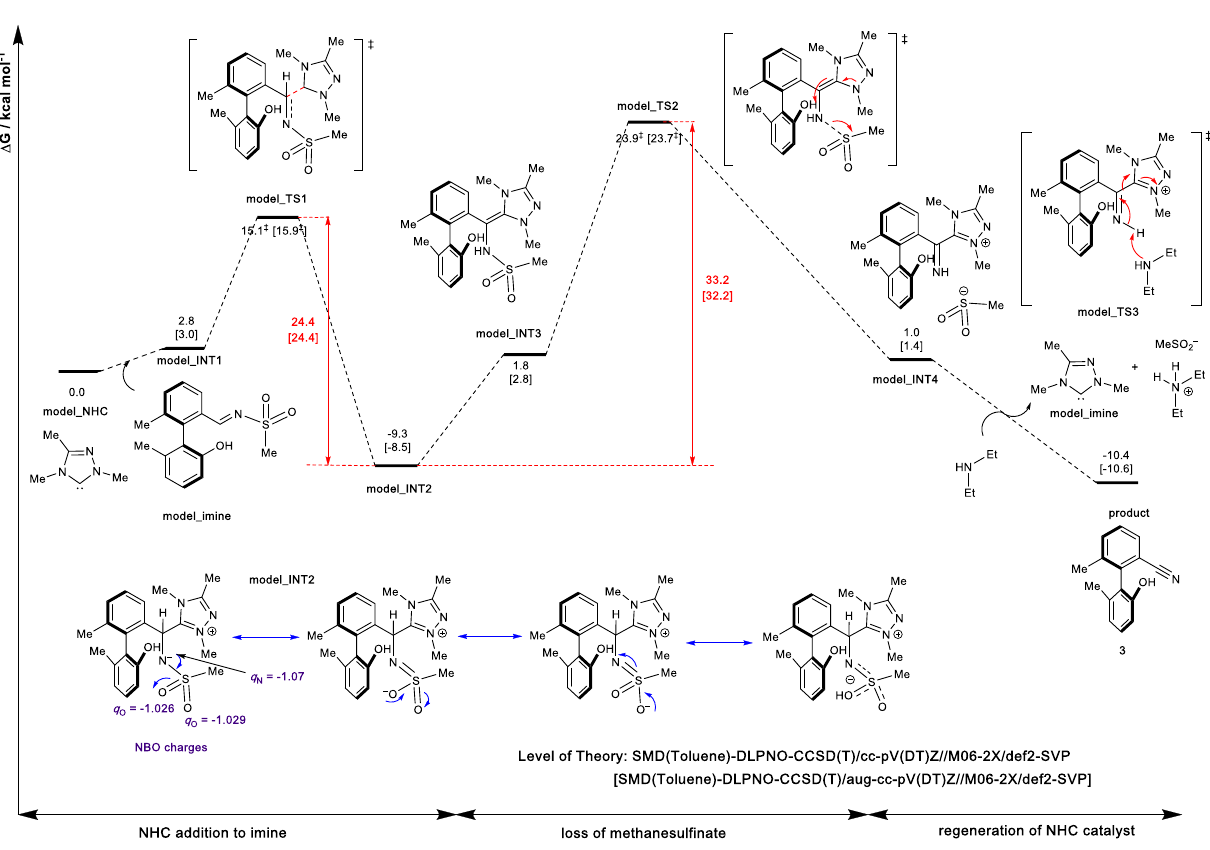
Fig. 2 Gibbs energy pro fi le for the model reaction system. The rate-limiting step is the loss of methanesul fi nate, model_TS2 . The addition of NHC, model_TS1 , is reversible. The step of loss of anion in the full system is both the rate-limiting and stereo-determining